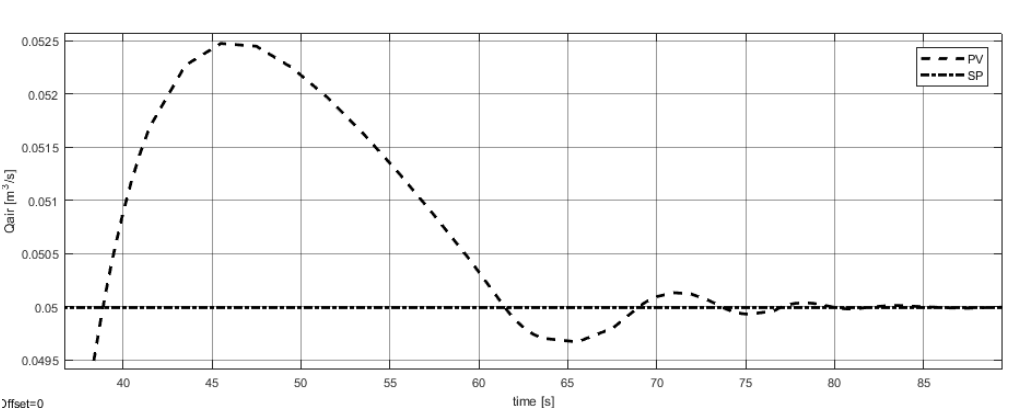
Figure 7. Step response of the first fuzzy control system.